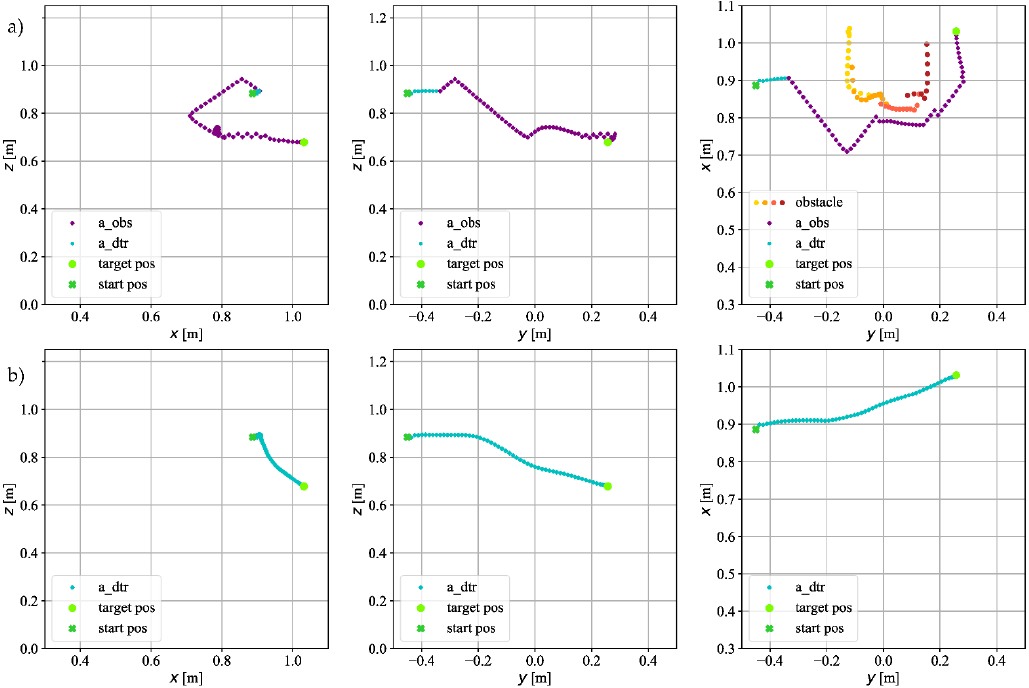
Figure 11. The trajectory on which the TCP of the robot moved in experimental research for goal point 𝑔 3 : ( a ) with an obstacle; ( b ) without an obstacle.